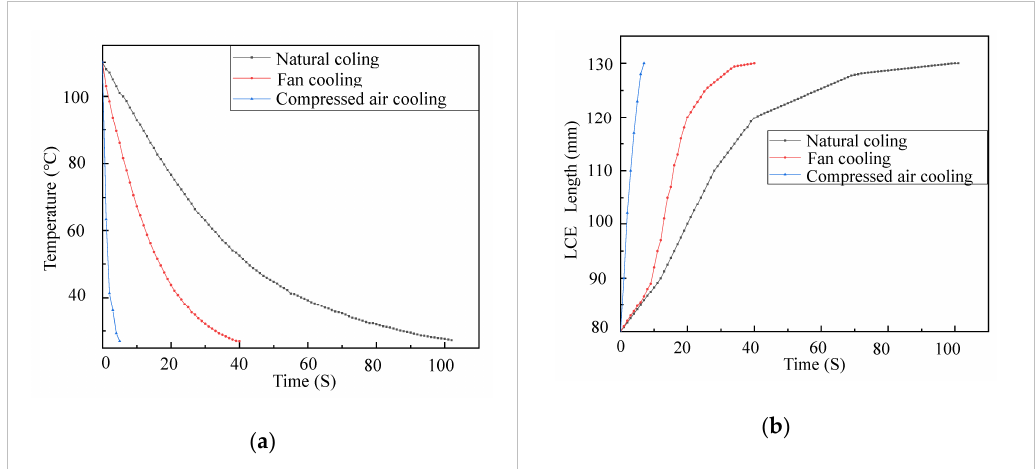
Figure 4. LCE tendon surface temperature drop ( a ) and extension ( b ) versus time using different cooling methods.